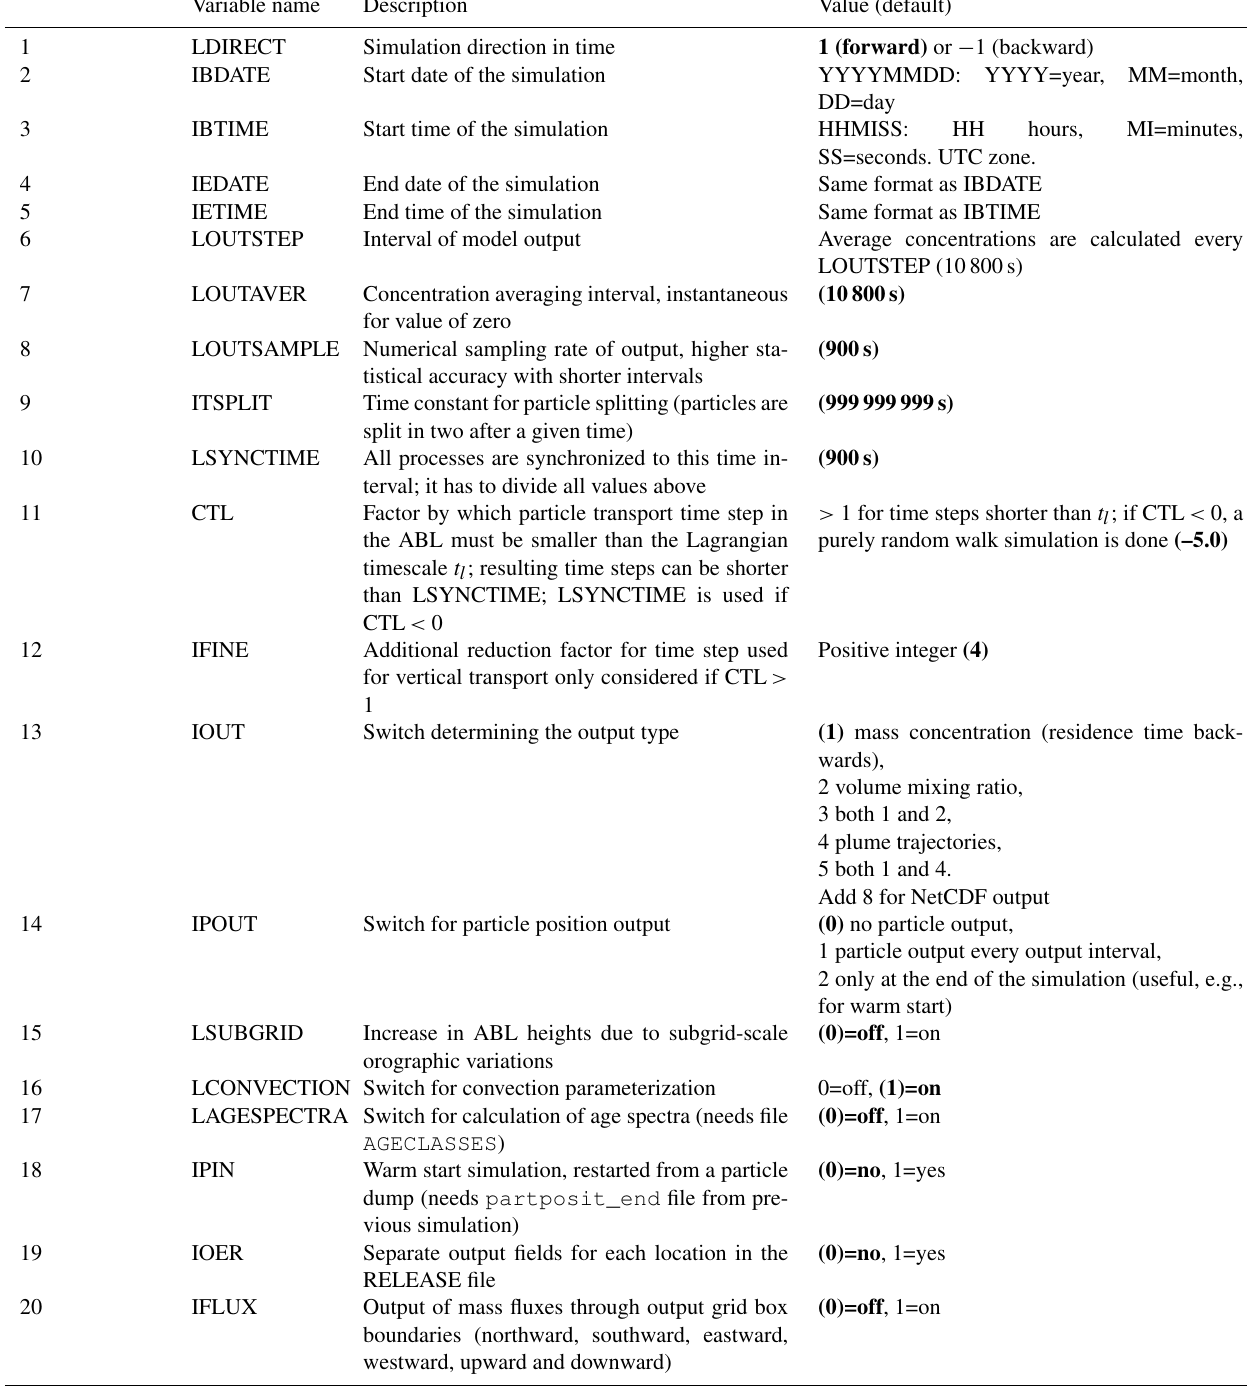
Table 8. Contents of the user input file COMMAND . Variable names with their meaning and all possible values are listed. Where appropriate, default values are given in bold. Note that not all input parameter combinations are